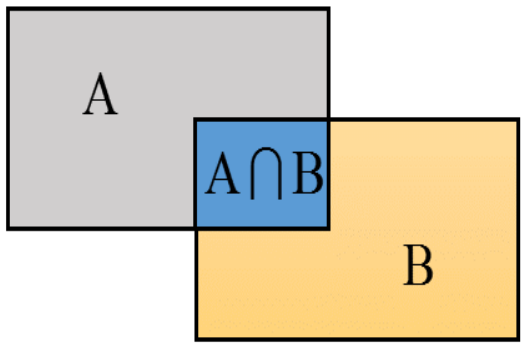
Figure 13. Sketch of Intersection over Union